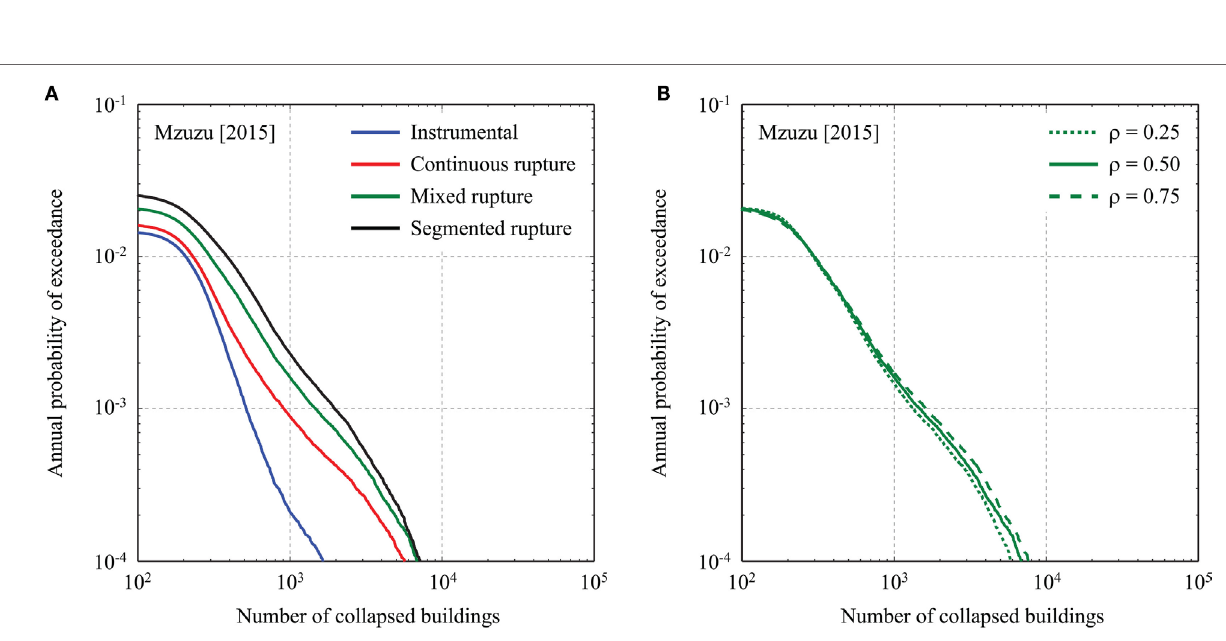
FigUre 11 | (a) Effects of different earthquake occurrence models on affected population curves (MMI > 6.5) for Mzuzu. (B) Effects of different MMI spatial correlation models (mixed rupture scenario) on affected population curves (MMI > 6.5) for